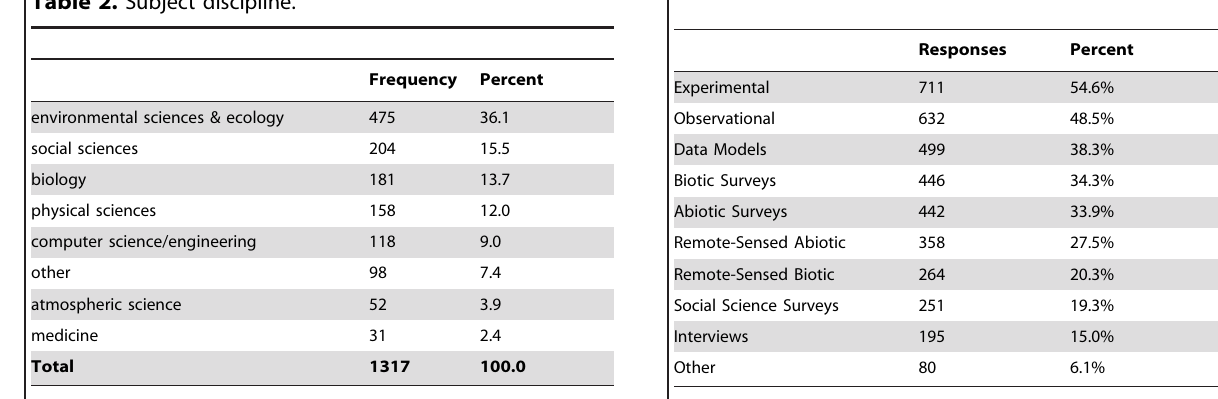
Table 4. Data types.